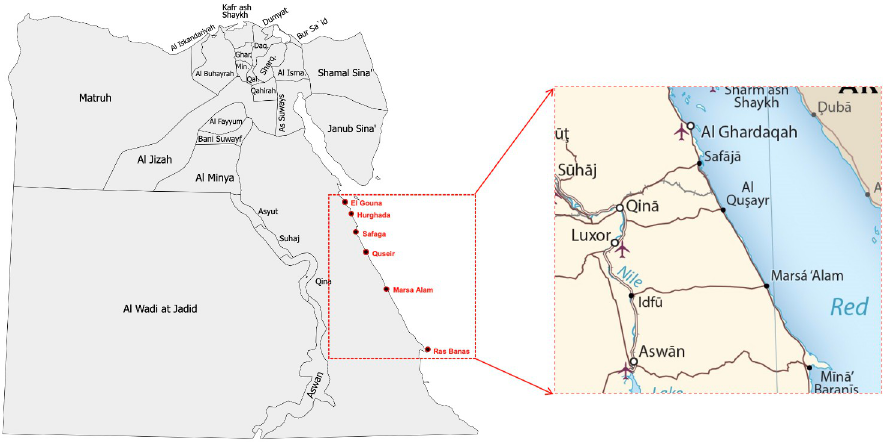
Fig 1. The southern Red Sea region, Egypt. Source: Adapted from